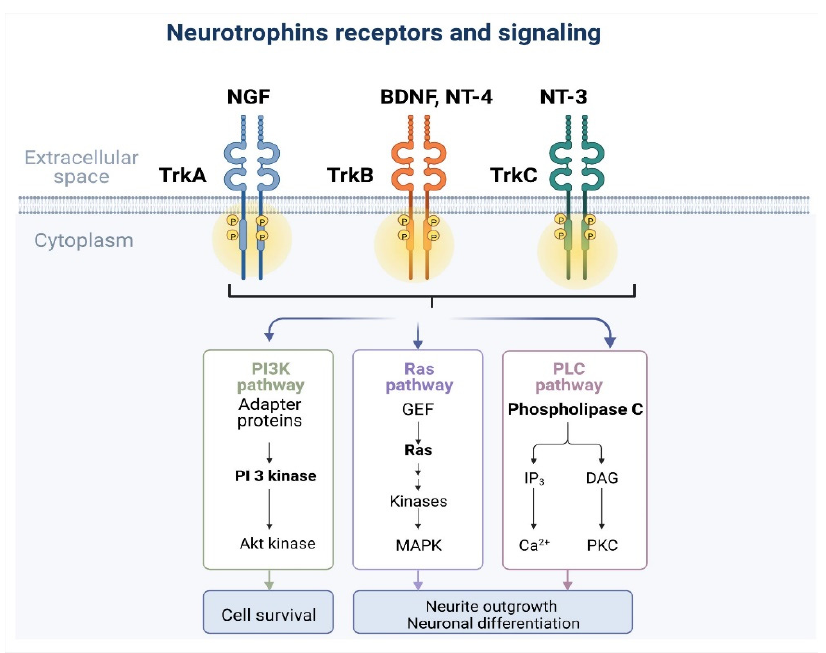
Figure 2. Schematic of Trk receptors and preference binding for neurotrophins. p75 signaling not depicted. Image created using Biorender.